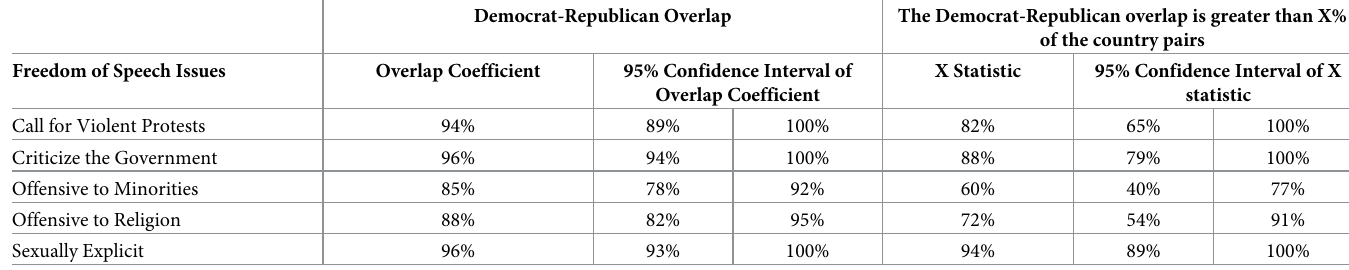
Table 2. Overlap coefficients for freedom of speech